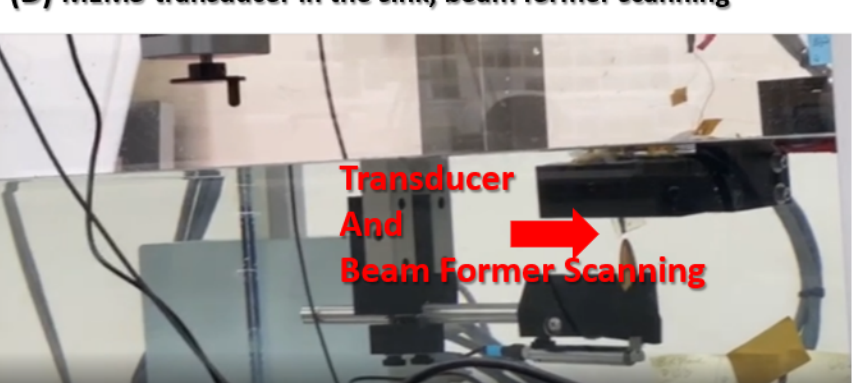
Figure 3. Channel 5 generated by ultrasonic energy was selected to increase the voltage supply. ( A ) The 16-channel circular MEMS-transducer array; ( B ) The PSM3750 Frequency Response Analyzer (Miko-Kings Instruments LTD, Fotan, Shatin, N.T, Hong Kong) was used for measuring the resonance frequency of the piezoelectric element; ( C ) Measured at MEMS-transducer Channel 5, the frequency and impedance at the resonance frequency were 2.3759 MHz and 19.729 Ω , respectively; ( D ) After putting the MEMS-transducer in the sink, beamforming was performed to scan its ultrasonic resonance energy. Beamforming was performed to scan the ultrasonic resonance energy of the MEMS- transducer and to detect ultrasound signals, as shown in Figure 4.